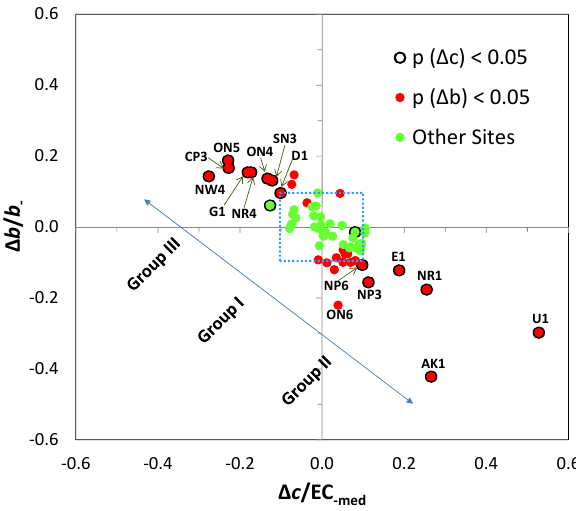
Figure 4. Fig. 4. Changes in EC- τ R robust regression intercept ( 1c) /slope ( 1b) relative to median EC (EC − med ) /regression slope ( b − ) prior to 2005. Red: significant change in slope ( p < 0 . 05); solid edge: significant change in intercept ( p < 0 . 05); green: all other sites without significant changes. Group I consists of 36 sites with 1b not significantly different from zero. Group II consists of 17 sites with negative 1b that are significantly different from zero, and Group III consists of 12 sites with positive 1b that are significantly different from